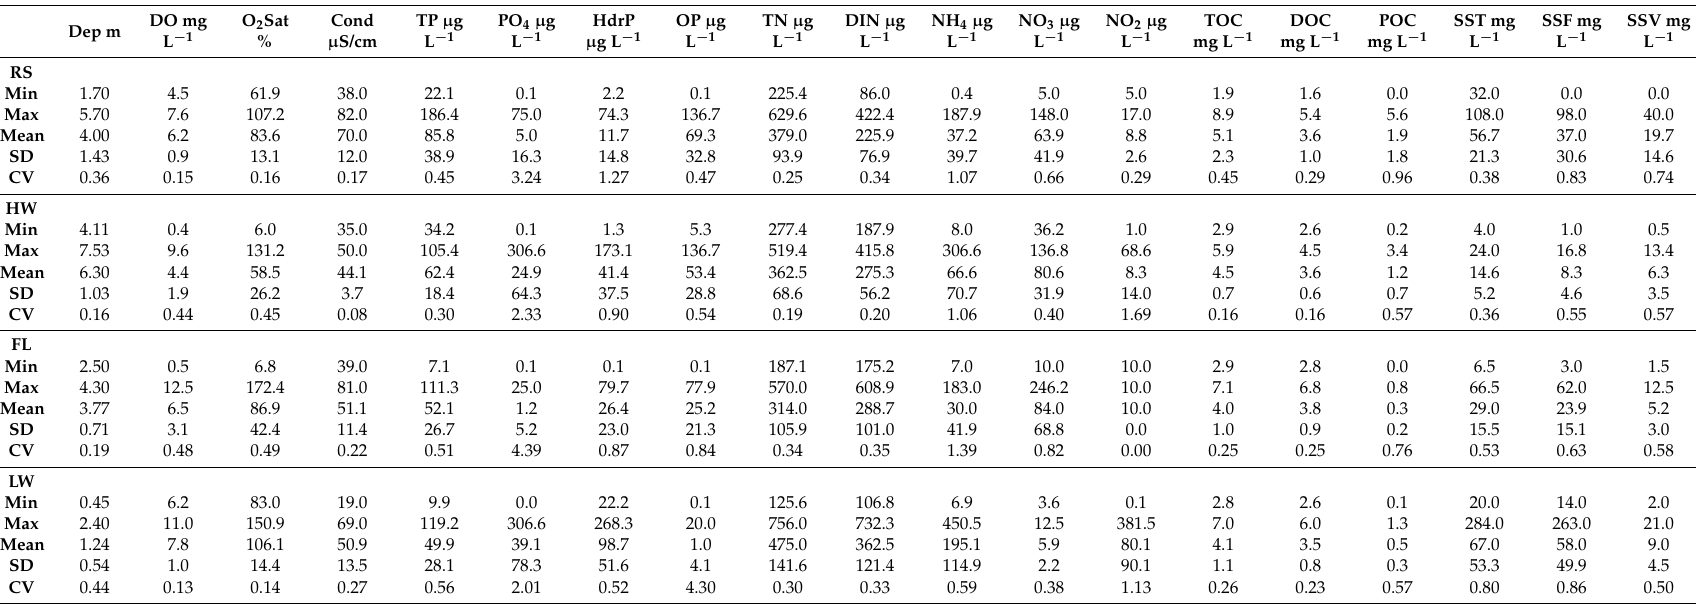
Table 1. Summary of environmental and nutrients data analyzed. Depth (Dep), dissolved oxygen (DO), oxygen saturation (O 2 Sat), electrical conductivity (Cond), total phosphorus (TP), orthophosphate (PO 4 ), hydrolysable reactive phosphorus (HdrP), organic phosphorus (OP), total nitrogen (TN), dissolved nitrogen (DIN), ammonium (NH 4 ), nitrate (NO 3 ), nitrite (NO 2 ), total organic carbon (TOC), dissolved organic carbon (DOC), particulate organic carbon (POC), total suspended solids (TSS), fixed suspended solids (FSS), volatile suspended solids (VSS). Minimum value recorded (Min), maximum value recorded (Max), standard deviation to mean (SD).